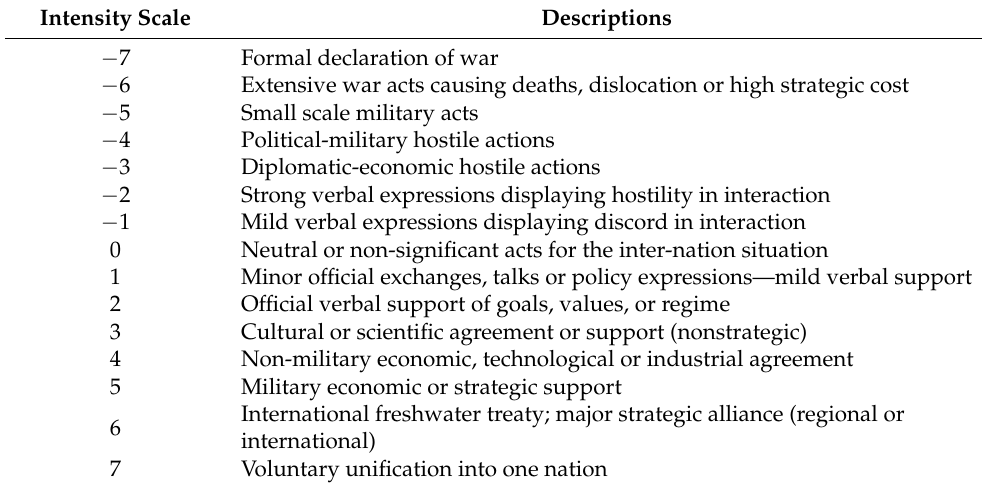
Table A1. The intensity scale of TWC events